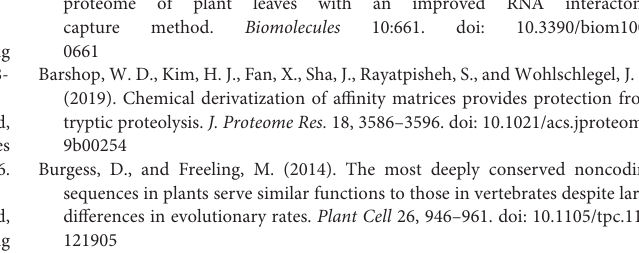
Solutions for the Analysis of Molecular Sequence Data, 2019). (B) Comparison between the sequence of sno- COBRA1A and sno- COBRA1B and their human homologs. Performed using blastn suite from the NCBI aligning two of more sequences (Zhang et al., 2000). Supplementary Figure 3 | lncCOBRA1 is transcribed as a longer transcript with conserved promoter elements. (A) Diagram of lncCOBRA1 representing the location of the RT-PCR primers (green arrows). (B) RT-PCR in cDNA from seeds 1- and 2-day-after soaking in water, and 2-, 3-, 4-, and 5-day-old seedlings. Water is a negative control and genomic Col-0 DNA was used as a positive control. Ladder is 1 kb plus. (C) Diagram of the promoter region and conserved elements. Yellow boxes indicate Site II elements, and the purple box represents a Telo-box, together forming a Telo SII element. The orange box represents a conserved non-coding sequence (CNS) and the green box represents a TATA-box. Supplementary Figure 4 | Loss of lncCOBRA1 slightly affects rRNA abundance. (A) Gel image confirming large deletion caused by two guide RNAs targeted to the 5 (cid:48) end of lncCOBRA1 . GAPDH is a positive control. (B) Diagram of lncCOBRA1 representing the location of the T-DNA insertion in lnccobra1-1 , location of guide RNAs and actual sites of deletion (represented by red triangles) for lnccobra1-2 . (C) Relative abundance of COBRA1 in Col-0, lnccobra1-1, and lnccobra1-1/lncCOBRA1pro:lncCOBRA1 using primer set 2 as measured by qPCR. Abundance is normalized by UBC9 and UBC10 and is relative to Col-0. ∗∗∗ Denotes p -value < 0.001; Wilcoxon t -test. N = 3. Error bars represent SEM. (D) Relative abundance of lncCOBRA1 (set 1), 5.8S , 18S , and 25S rRNA in Col-0, lnccobra1-1, lnccobra1-2 , and lnccobra1-1/lncCOBRA1pro:lncCOBRA1 . Abundance is normalized by UBC9 and UBC10 and is relative to Col-0. ∗∗∗ Denotes p -value < 0.001; Wilcoxon t -test. N = 3. Error bars represent SEM. (E) Total RNA isolated from Col-0, lnccobra1-1, lnccobra1-2 , and lnccobra1-1/lncCOBRA1pro:lncCOBRA1 on a 1.5% denaturing agarose gel. Supplementary Figure 5 | Loss of lncCOBRA1 results in smaller plants. (A) Representative images generated from ImageJ to measure perimeter of 3-week-old plants. Images on top and bottom are the same plants, with the top being used for perimeter measurements and the bottom used for area measurements. (B) Leaf area of leaf three measured by ImageJ. ∗ Denotes p -value < 0.05; Wilcoxon t -test. Supplementary Figure 6 | lncCOBRA1 does not interact with rRNAs. (A) Relative abundance of 5.8S rRNA , 18S rRNA , and 25S rRNA in ChIRP-MS experiments. Abundance is normalized by U6 and relative to Col-0 input. Error bars represent SEM. ns and ∗∗ , denotes p -value > 0.05 and < 0.01, respectively; Wilcoxon t -test. N = 3. (B) Overlap between lncCOBRA1 -interacting proteins and proteins classified as RBPs in an RNA binding proteome capture experiment in Arabidopsis leaves. ∗∗∗ Denotes p -value < 0.001; Hypergeometric test. (C) Gene ontology enrichment analysis for biological function using Plant Regulomics (Ran et al., 2020) for COBRA1 -interacting proteins. Size of circles represents –log 10 ( p -value). Supplementary Figure 7 | lncCOBRA1 -interactome. (A) Protein–protein interaction (PPI) network for lncCOBRA1 -interacting proteins. Proteins were clustered into five clusters by k-means clustering. Thickness of lines connecting notes indicates the confidence of that protein-protein interaction. Dotted line indicates interaction with a different cluster. (B) Gene ontology enrichment for proteins in each cluster (Huang et al.,